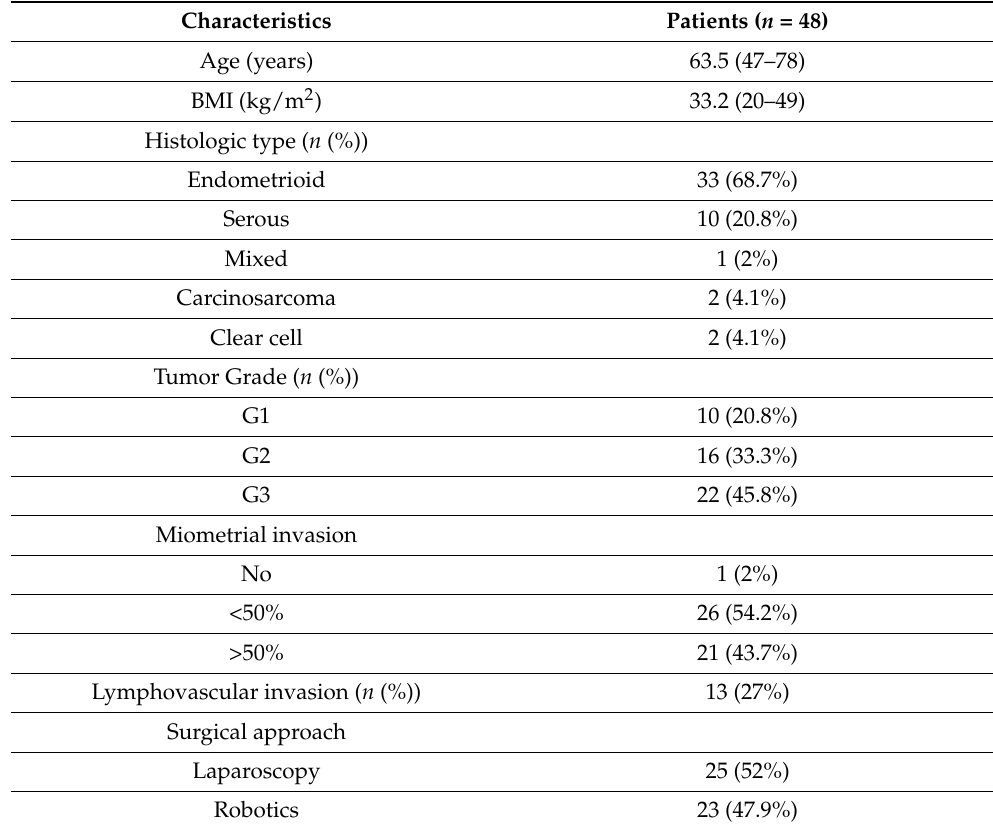
Table 3. Patients and tumor characteristics.